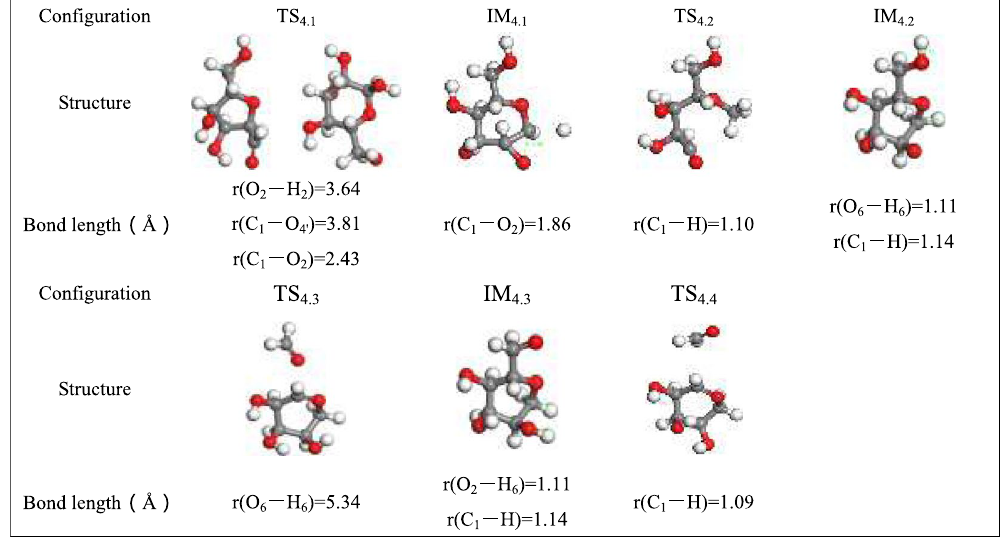
Table 5. Optimized configuration in pathway